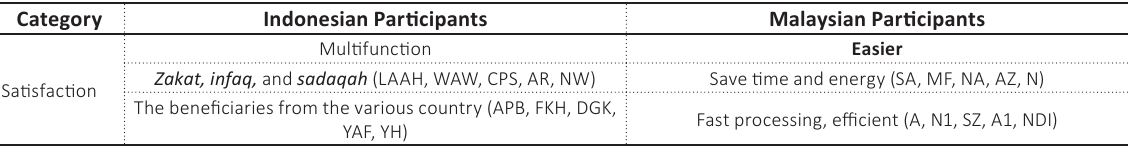
Table 5. Satisfaction of Fintech